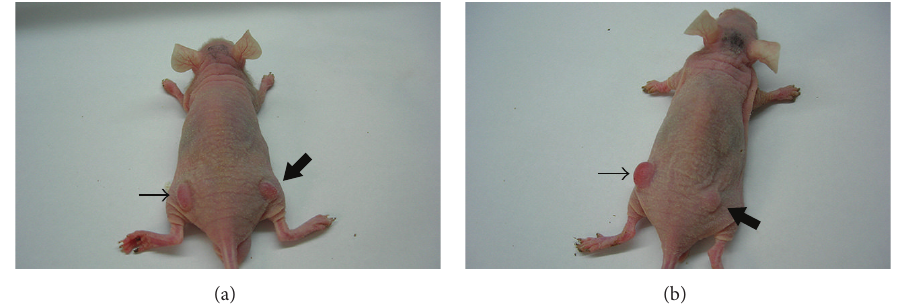
Figure 5: Representative images showing ablation of subcutaneous xenograft tumors by intraperitoneal ganciclovir (GCV) administration in nude mice. Thin arrow indicated xenograft tumors derived from control C6 cells, while thick arrow represented tumors that originated from either C6-TK cells (a) or C6-sr39TK cells (b). Although complete tumor ablation was not achieved, tumors in the mutant TK groups were significantly smaller than that from the wildtype TK or control